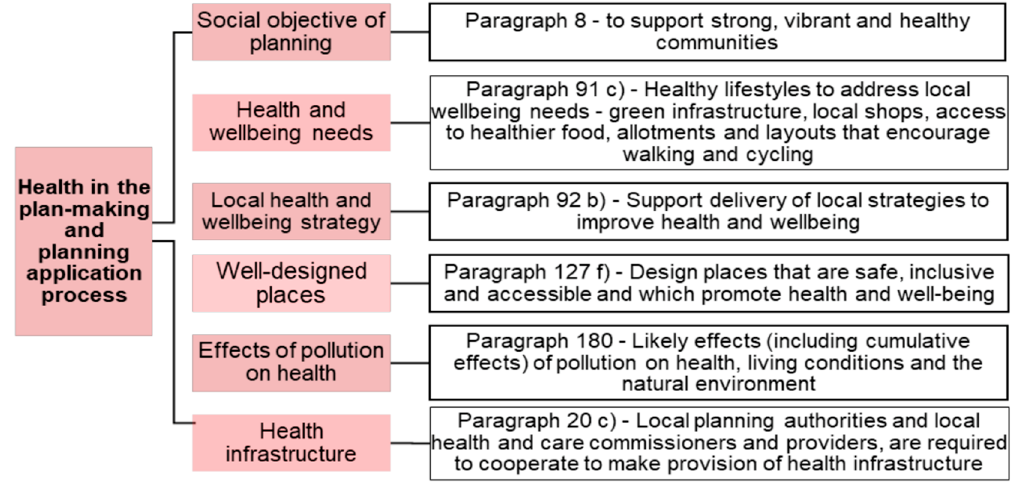
Figure 1. Health policy elements in the National Planning Policy Framework 2012 (source: PHE 2020 [11]).